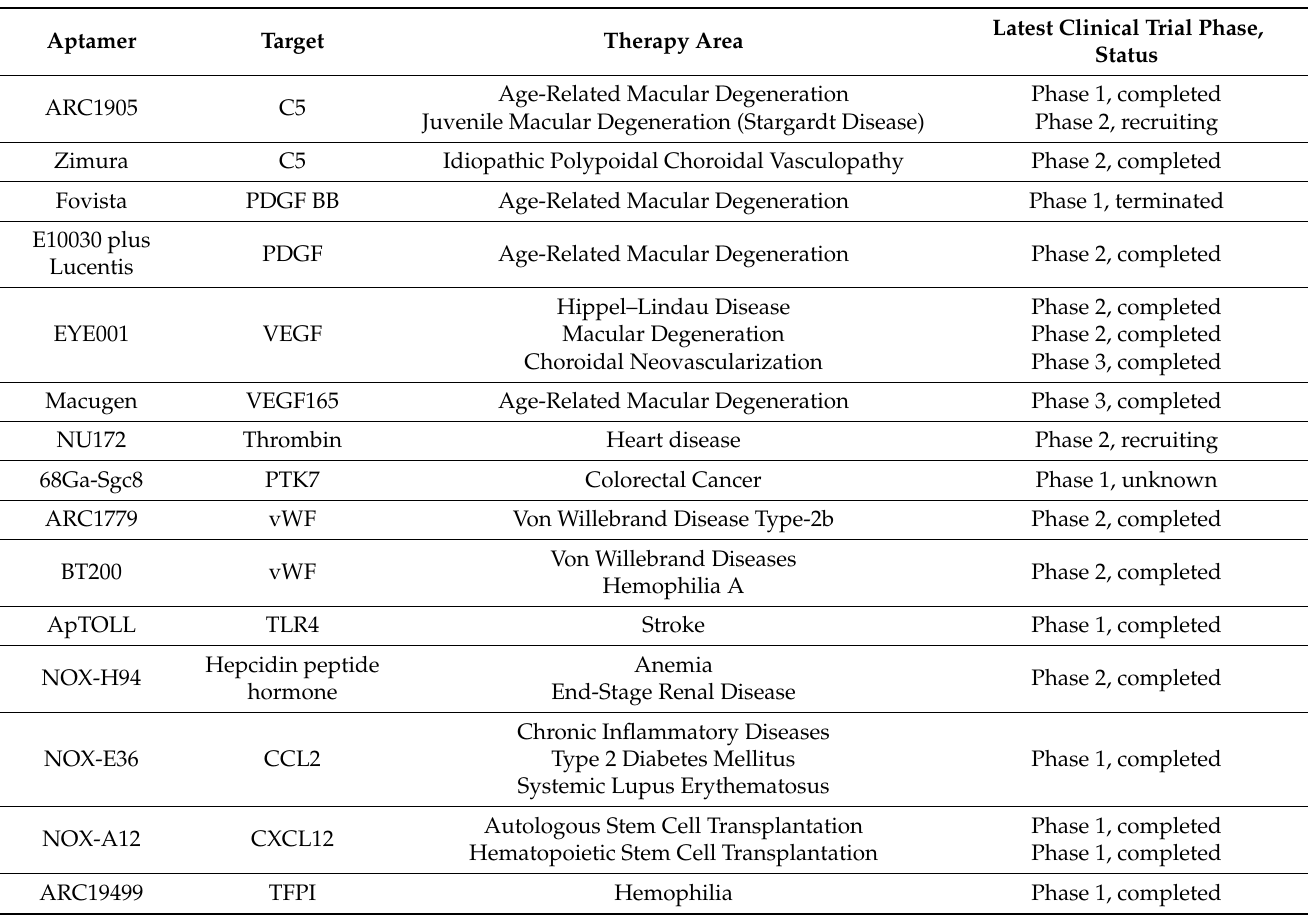
Table 5. Therapeutic aptamers currently in clinical